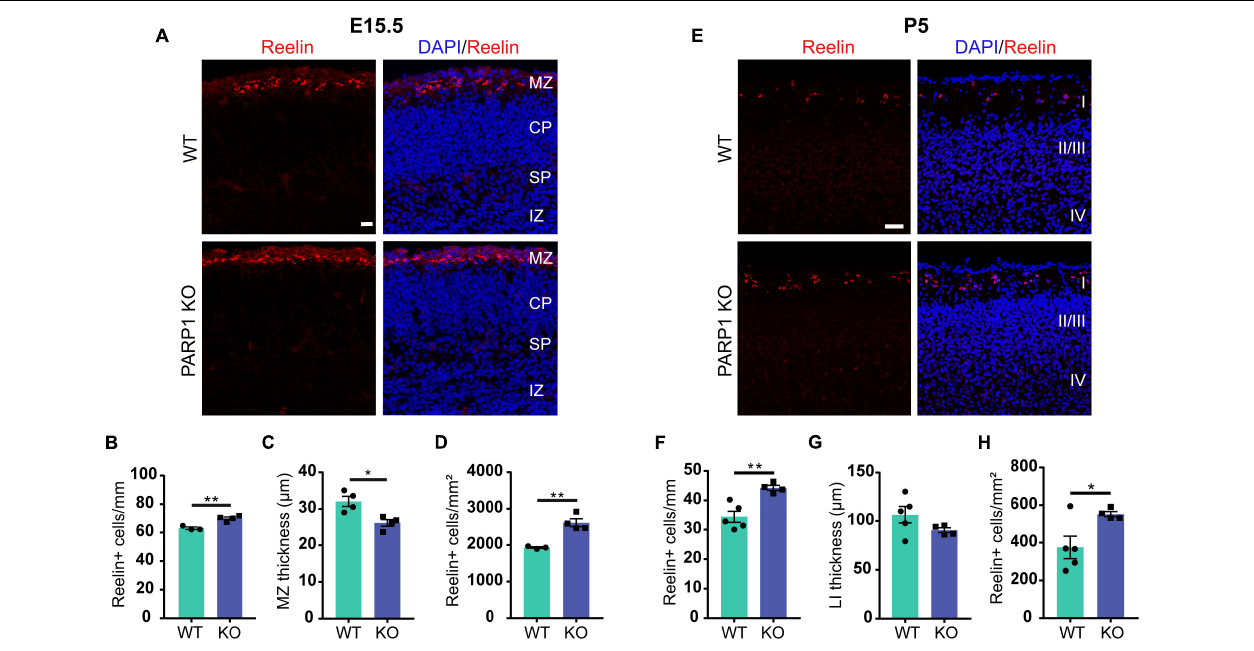
FIGURE 4 | Loss of PARP1 increases the number of Cajal–Retzius cells in the E15.5 and P5 cortex. (A) Representative images of coronal sections of brain cortex from E15.5 WT and PARP1 KO embryos following Reelin immunostaining (red). Nuclei are labeled with DAPI (blue). Scale bar, 20 µ m. Marginal zone (MZ), cortical plate (CP), subplate (SP), and intermediate zone (IZ) are labeled. MZ is defined as area containing diffuse Reelin staining. (B) The number of Reelin-expressing cells along the marginal zone is increased, (C) marginal zone thickness is decreased, and (D) Reelin+ cell density is increased in the KO E15.5 brain ( n = 4 for each genotype from 7 L, three sections per animal including rostral, medial, and caudal regions, and three images per section). ** p < 0.01 by Student’s unpaired t -test. (E) Representative images of coronal sections of cortex from P5 WT and PARP1 KO embryos showing Reelin immunostaining in red. Nuclei are labeled with DAPI (blue). Scale bar, 50 µ m. (F) The number of Reelin-expressing cells in layer I is increased, (G) layer I (LI) thickness shows a decreasing trend, and (H) density of Reelin-expressing cells in layer I is increased in the P5 KO brain ( n = 4 WT and 5 KO from 8 L, three sections per animal from rostral, medial, and caudal brain regions, and three images per section). * p < 0.05 and ** p < 0.01 by Student’s unpaired t -test. p = 0.15 for P5 LI